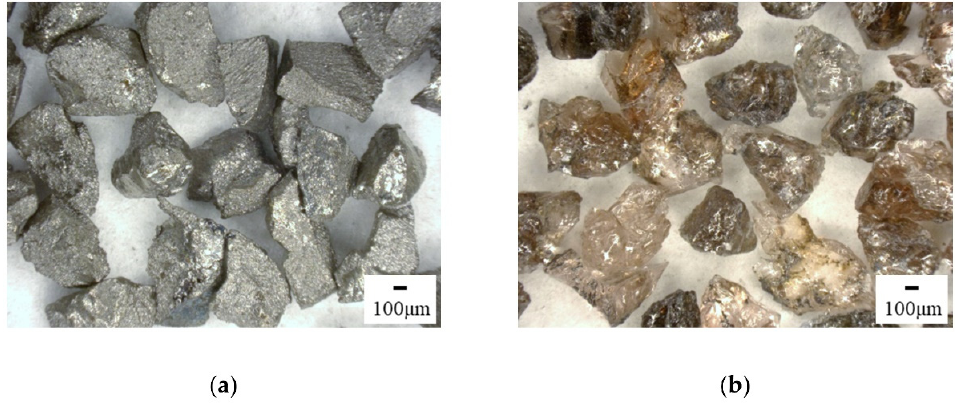
Figure 1. Micrograph of abrasive materials: ( a ) Steel grit; ( b ) Aluminum grit. Table 2. Chemical composition of abrasive materials.